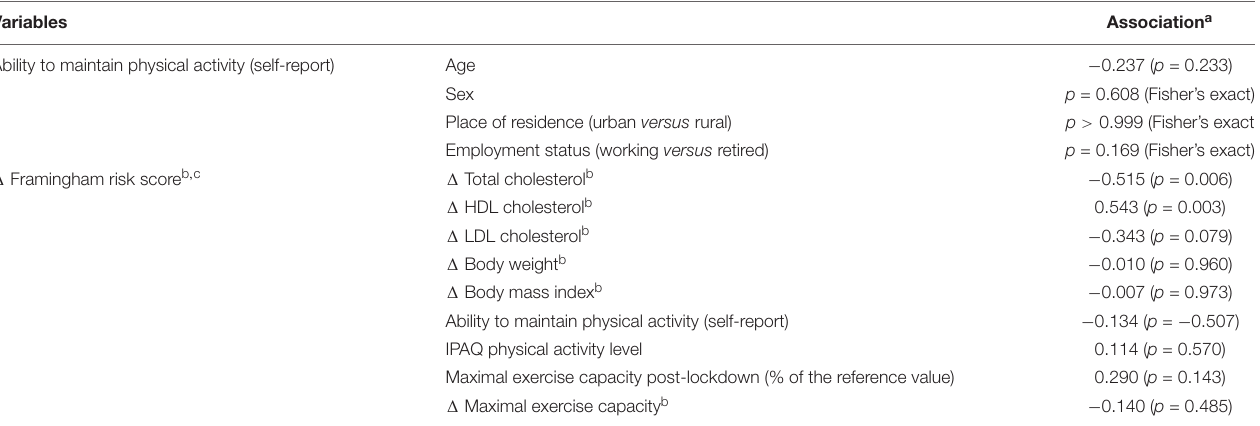
TABLE 4 | Associations with ability to maintain physical activity and Framingham risk score.